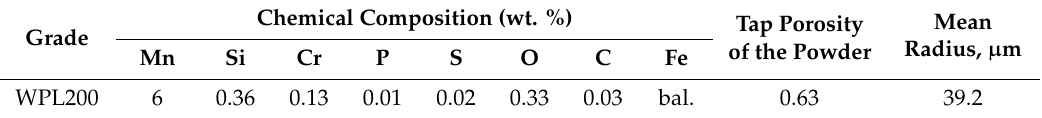
Table 1. Chemical composition of WPL200 powder [68]. Chemical Composition (wt.